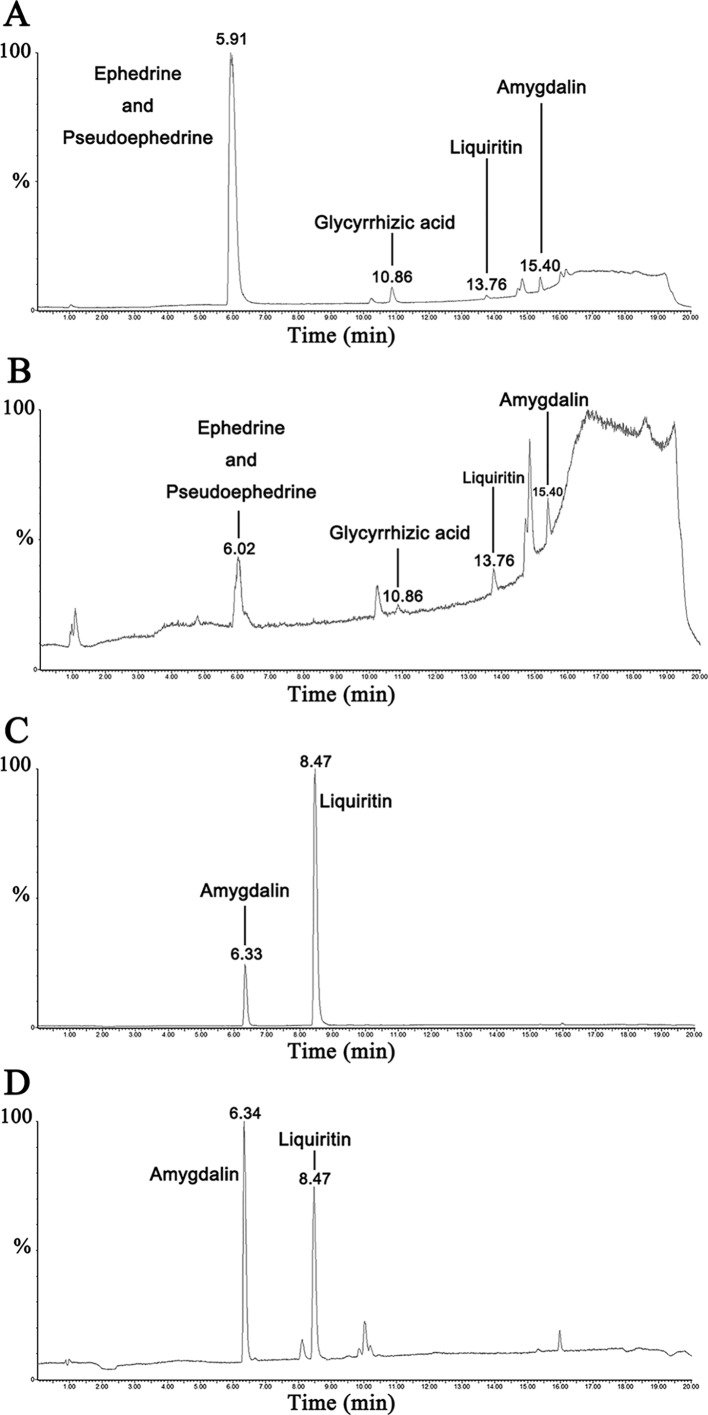
Representative chromatograms of reference standard solution and MXD sample. (A) Representative chromatograms of standard solution in positive electrospray ionization mode. (B) Representative chromatograms of MXD sample in positive electrospray ionization mode. (C) Representative chromatograms of standard solution in negative electrospray ionization mode. (D) Representative chromatograms of MXD sample in negative electrospray ionization mode.